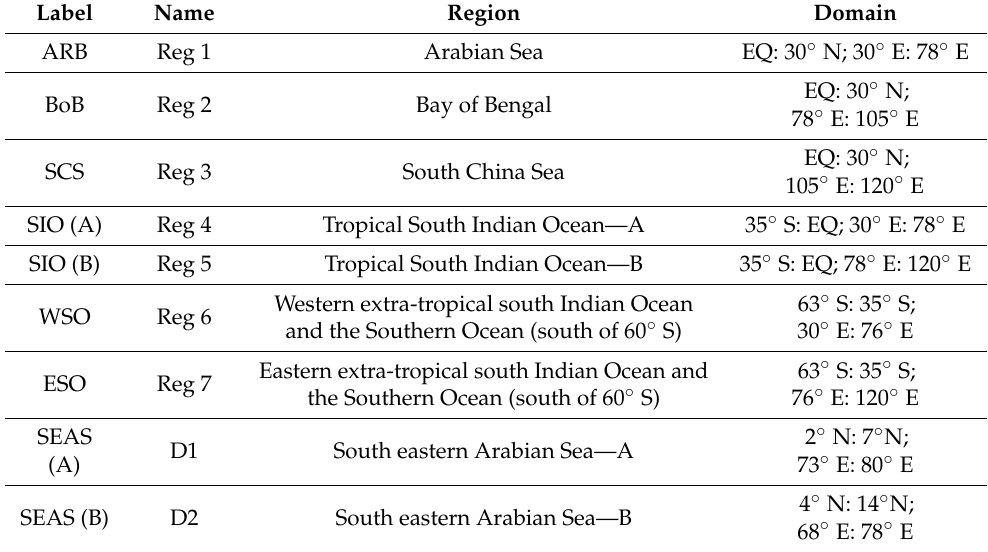
Table 2. Details of sub-domains in the Indian Ocean region used for the study.